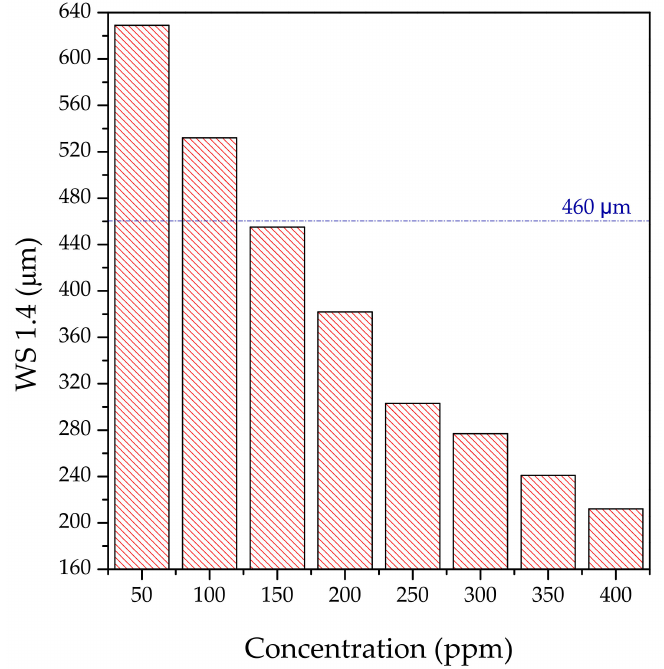
Figure 6. Impact of coconut oil N , N -Bis(2-ethoxyethyl) amides addition on the lubrication character- istics of the base fuel.